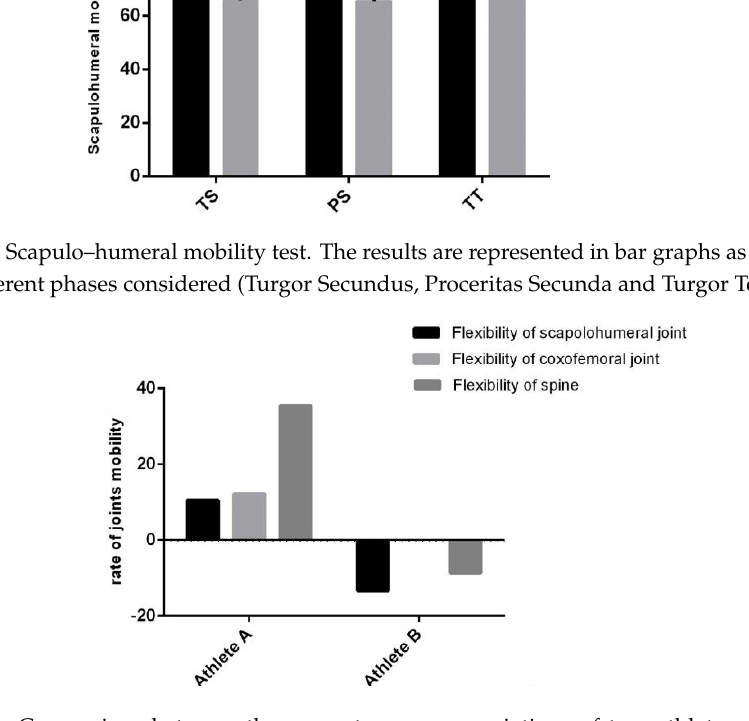
Figure 11. Scapulo–humeral mobility test. The results are represented in bar graphs as the mean ± SD of the different phases considered (Turgor Secundus, Proceritas Secunda and Turgor Tertius).